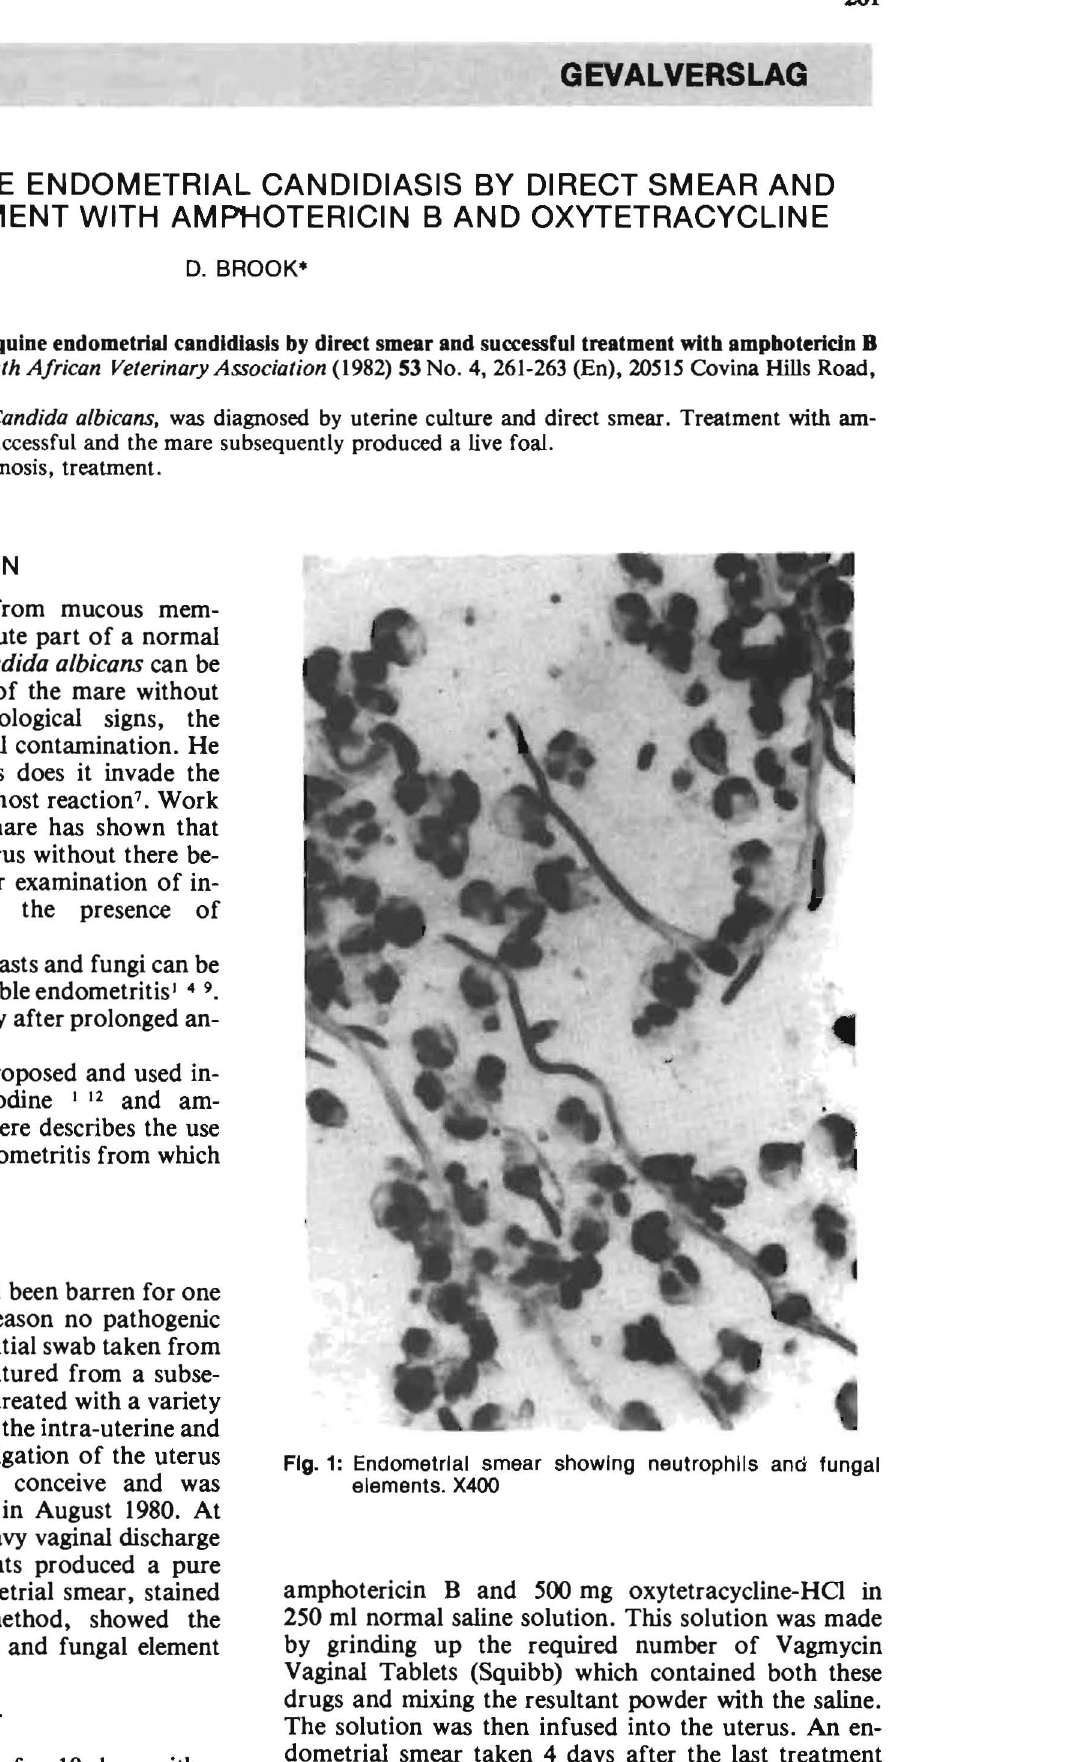
amphotericin Band 500 mg oxytetracycline-HQ in 250 ml normal saline solution. This solution was